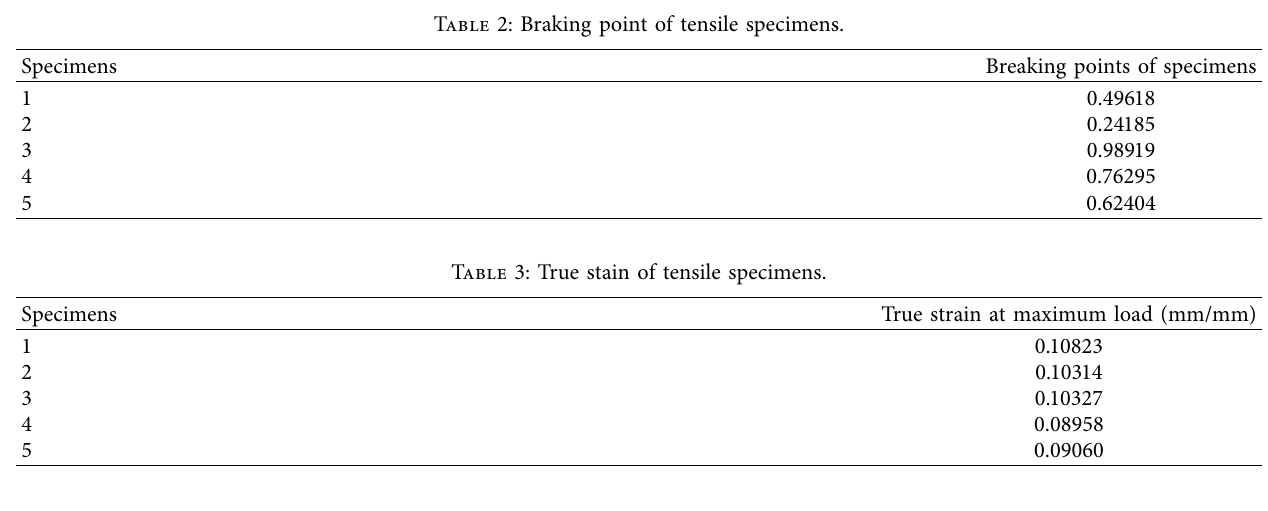
Table 4: True stain of tensile specimens.